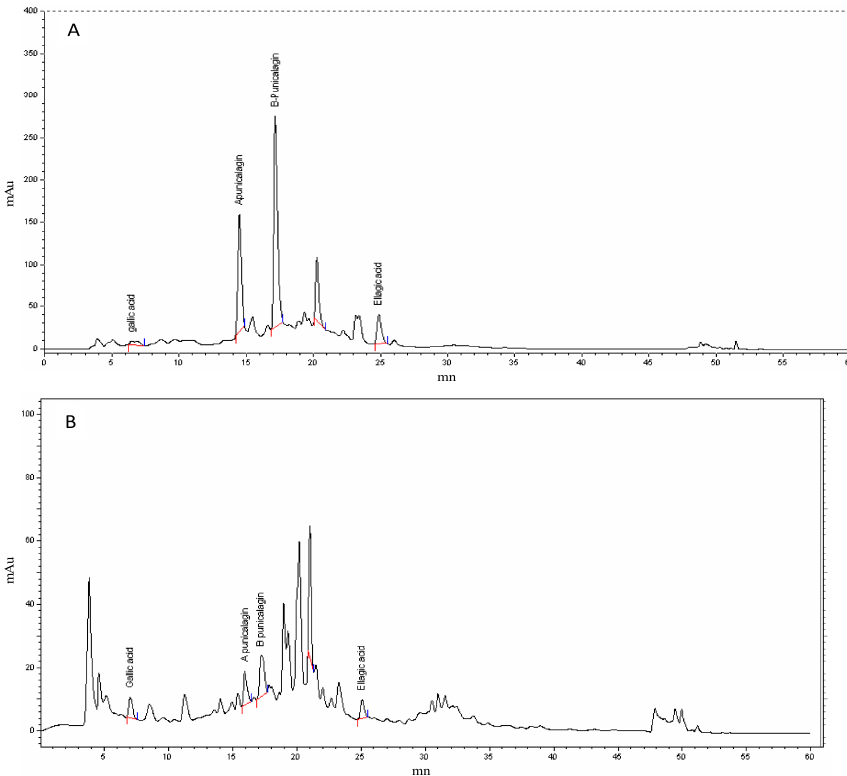
Figure 1. High-performance liquid chromatography-photodiode array (HPLC-PDA) chromatogram of bioactive molecules in ( A ): PPPE and ( B ): PAPE. The vertical red/blue lines correspond to the integration limits of each peak. Horizontal red lines correspond to peak detection threshold Table 2. Antioxidant activities of PPPE and PAPE. Results are expressed as the mean ± sem of at least three independent assays of each sample. * p < 0.05 and *** p < 0.001 indicate significant differences compared to the control.